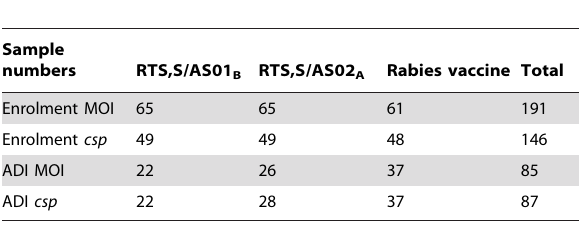
Table 1. Summary of sample numbers used for multiplicity of infection and csp sequence analysis.